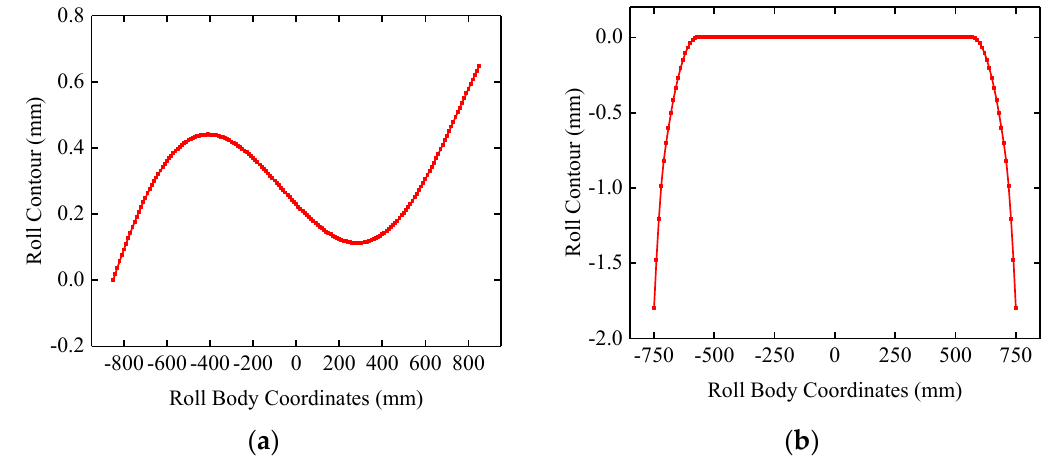
Figure 1. ( a ) Work roll contour; ( b ) original back-up roll contour.